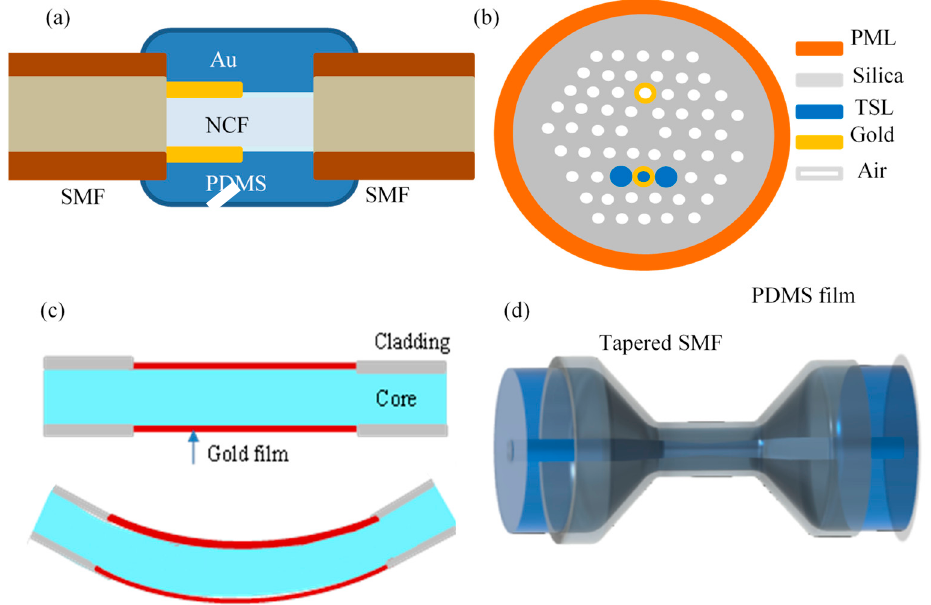
Figure 8. Physical sensor structure. ( a ) no-core fiber optic strain sensing [87]; ( b ) photonic fiber optic strain sensing [88]; ( c ) bend sensing [89]; ( d ) Pressure sensing [90]. PML, Perfect match layer; TSL, Temperature Sensitive Liquid.